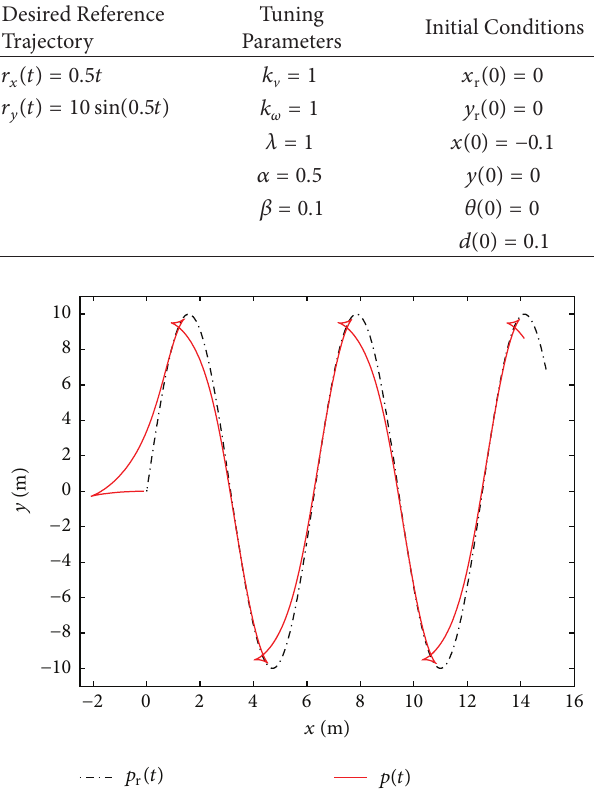
Table 1: Parameters for simulation without saturation.